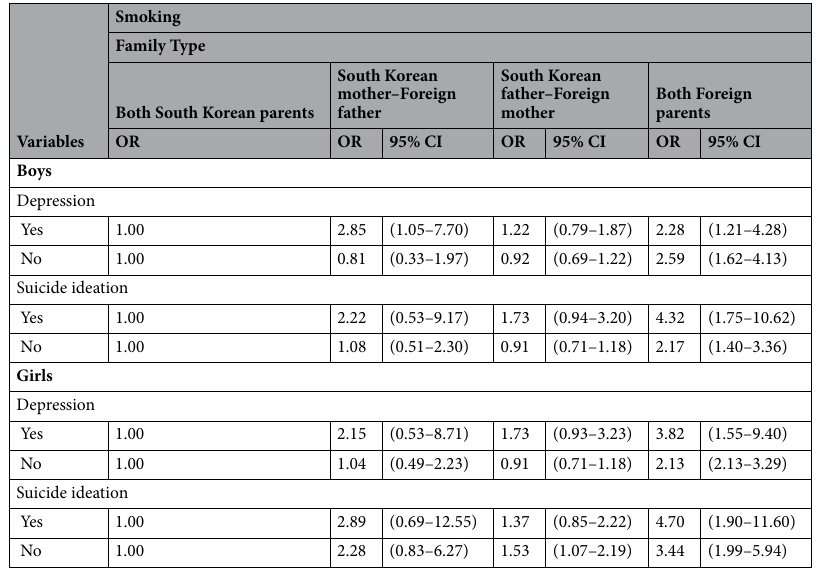
Table 3. Subgroup analysis stratified by independent variables.